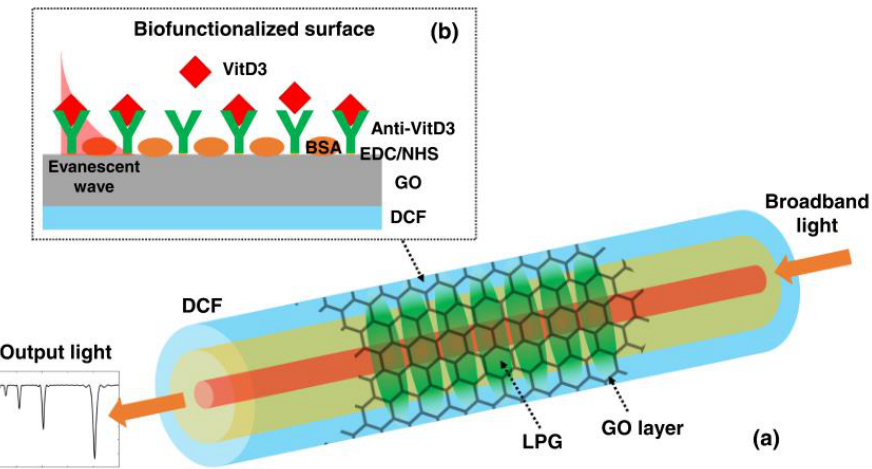
Figure 7. Schematic picture for the detection of vitamin D based on an LPFG in DCF with GO layer. ( a ) Overall schematic picture of the device; ( b ) Details regarding biofunctionalized fiber surface and sensing mechanism (not to scale). Adopted from [57]. Copyright © 2021, Elsevier.